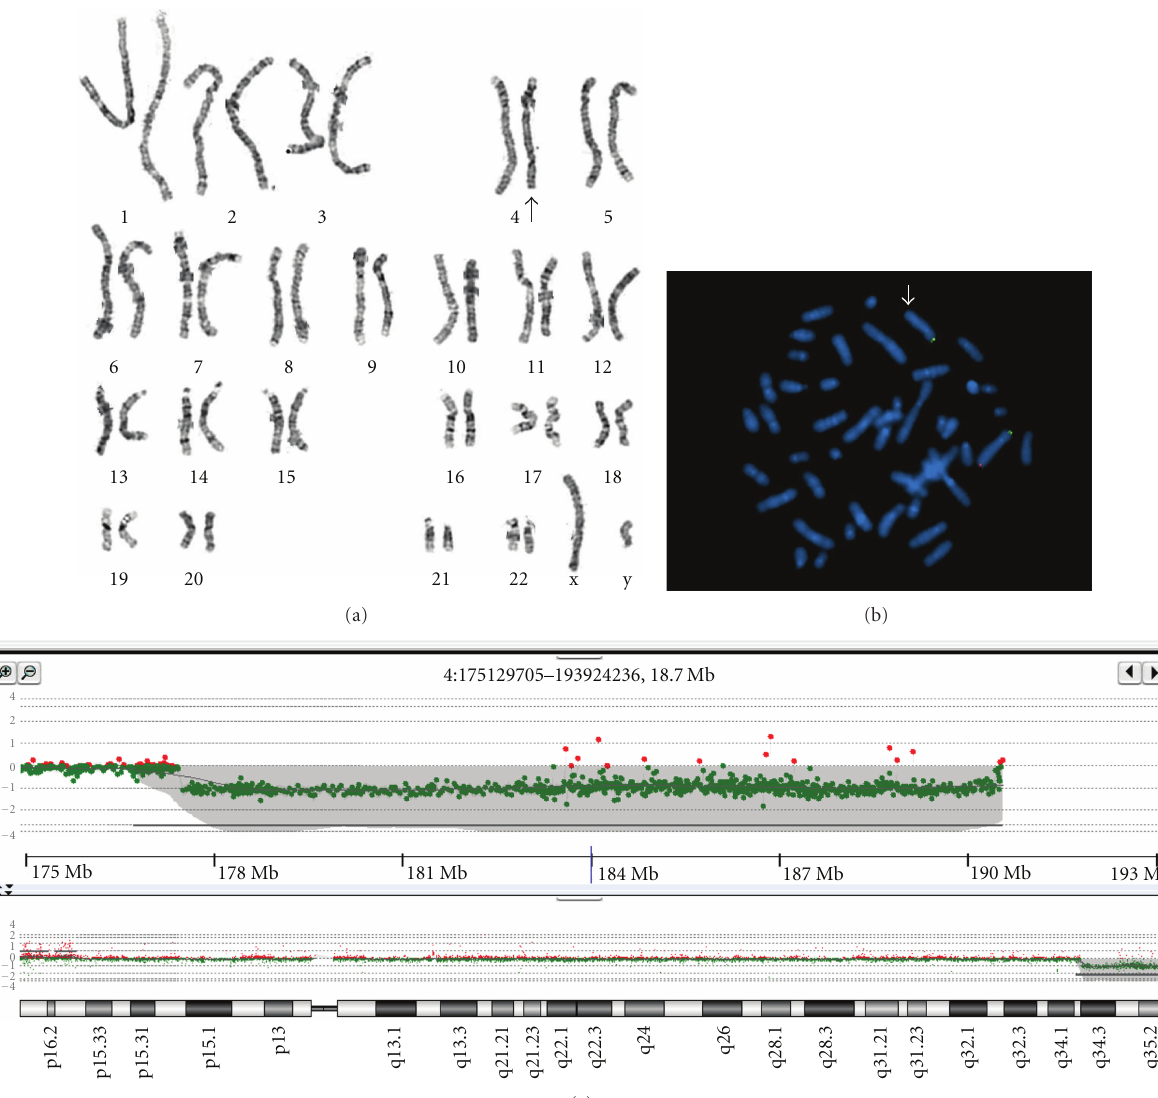
Figure 3: Trypsin-Giemsa karyotype 46,XY,del(4)(q33) from peripheral blood cells in the patient, the arrow indicates the abnormal chromosome 4 (a). Metaphase FISH image (b) from peripheral blood hybridized with Vysis 4p/4q subtelomere probes. The small arrow shows the deletion of the 4qsubtel region (red) on the abnormal 4q33 deletion chromosome. The 4psubtel region shows the normal green signals for both chromosomes 4. ish del(4)(q33)(4psubtel+; 4qsubtel − ). The array CGH (c) depicting the terminal deletion on long arm of chromosome 4 and its breakpoints. The deletion starts at 177,732,852 and ends at 191,279,059 bp on Chr4 and is nearly 13.5 Mb. There are 72 genes in the region based on NCBI Build 35.1 for Homosapiens